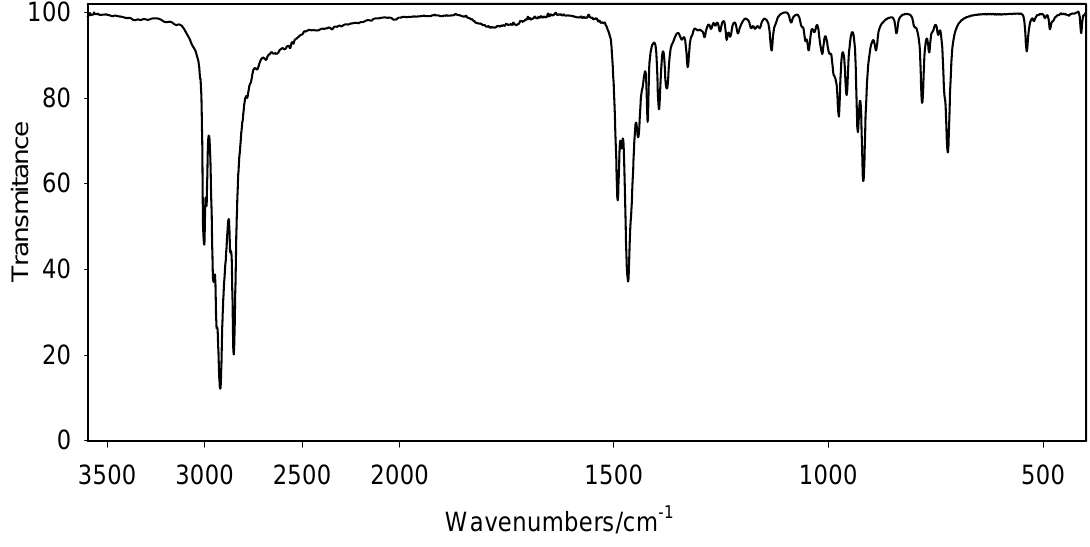
Figure 5. FTIR spectrum of ethylene-1,2-bis( N,N -dimethyl- N -dodecylammonium bromide) ( 5